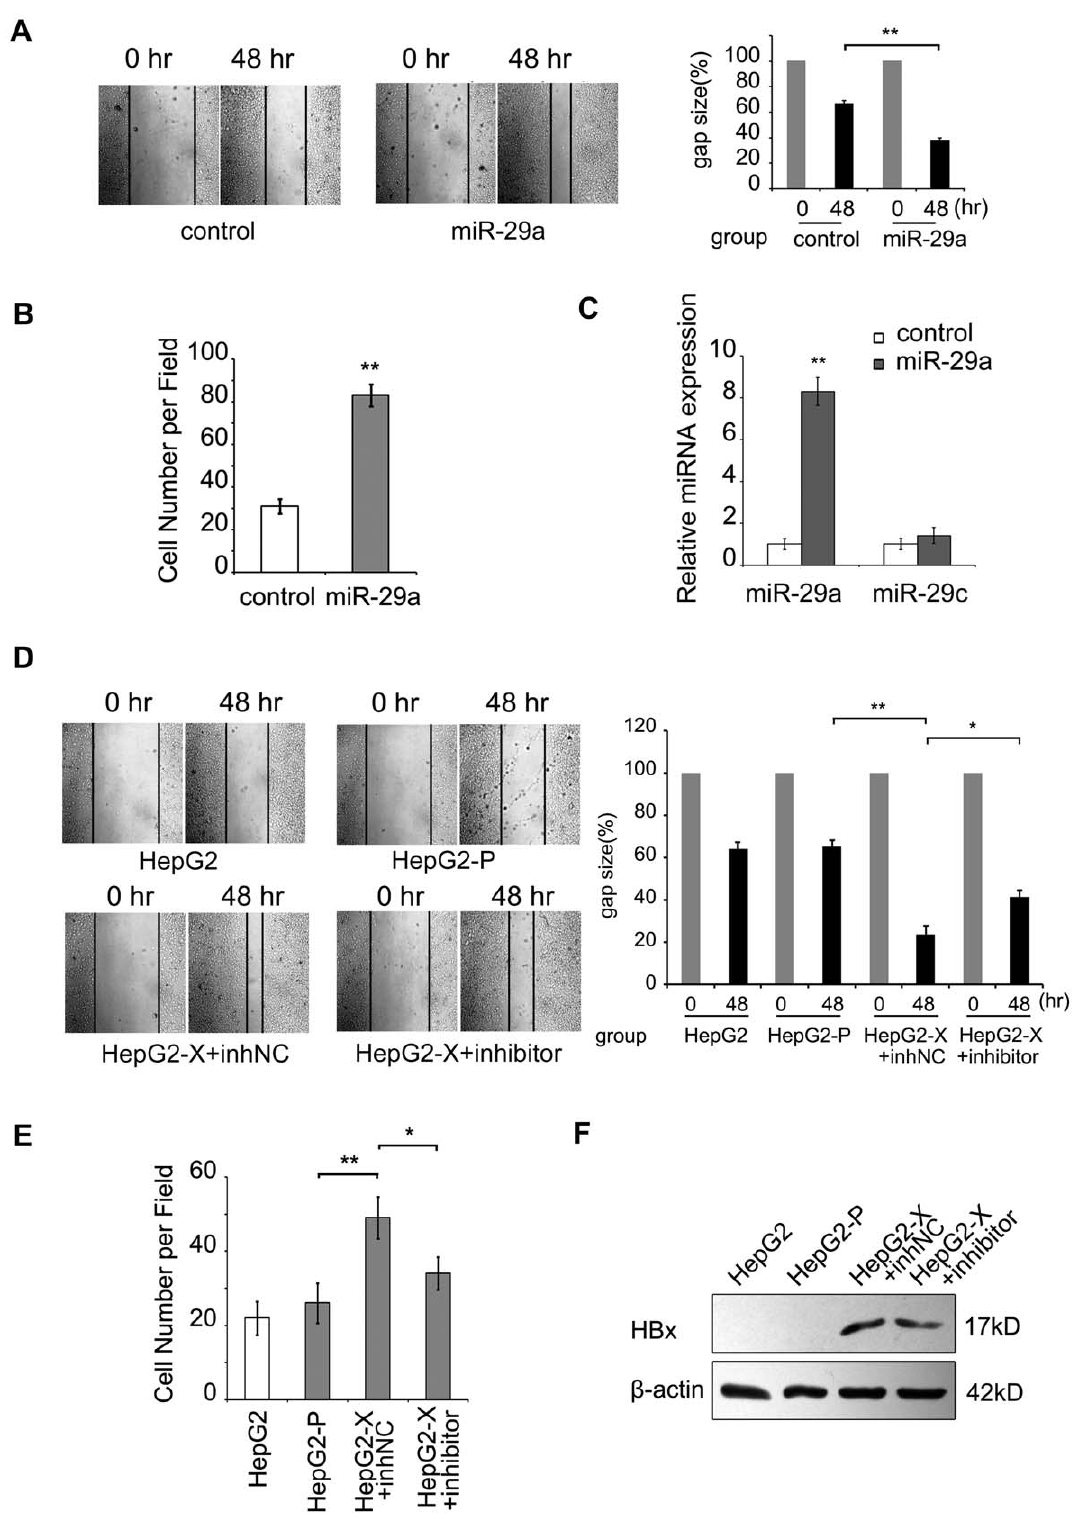
Figure 2. MiR-29a increases the migration of hepatoma cells. (A) A wound healing assay was performed on HepG2 cells (1 6 10 6 , 6-cm plate) transfected with either an empty vector (control) or a miR-29a expression vector (3 m g). One representative experiment is shown. Black arrows indicate the wound edge. The residual gap between the migrating cells from the opposing wound edge is expressed as a percentage of the initial scraped area. (B) Modified Boyden’s chamber assays showed that the cell migration was promoted by the miR-29a in HepG2 cells. A histogram shows the relative cell number of five randomly selected fields. (C) The expression levels of miR-29a and miR-29c were examined by qRT-PCR after overexpression of miR-29a in HepG2 cells. (D) A wound healing assay was performed on HepG2, HepG2-P and HepG2-X cells transfected with a miR-